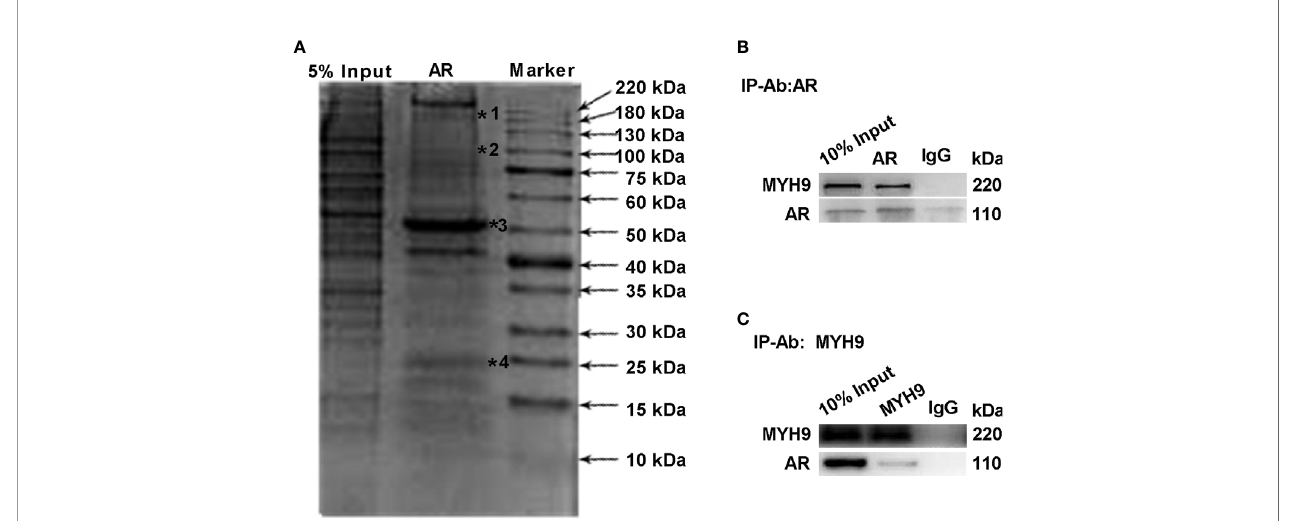
FIGURE 6 | MYH9 interacts with the AR. (A) AR pull-down proteins were separated by electrophoresis and stained with Coomassie Brilliant Blue R250. The arrows indicate the molecular weight of the protein ladder, and the stars indicate proteins in the gel identi fi ed by MS. * 1 to * 4 represent MYH9, AR, IgG heavy chains and IgG light chains in sequence. (B, C) The endogenous interacting AR and MYH9 were coimmunoprecipitated and detected by WB with their respective antibodies using LNCaP-AI